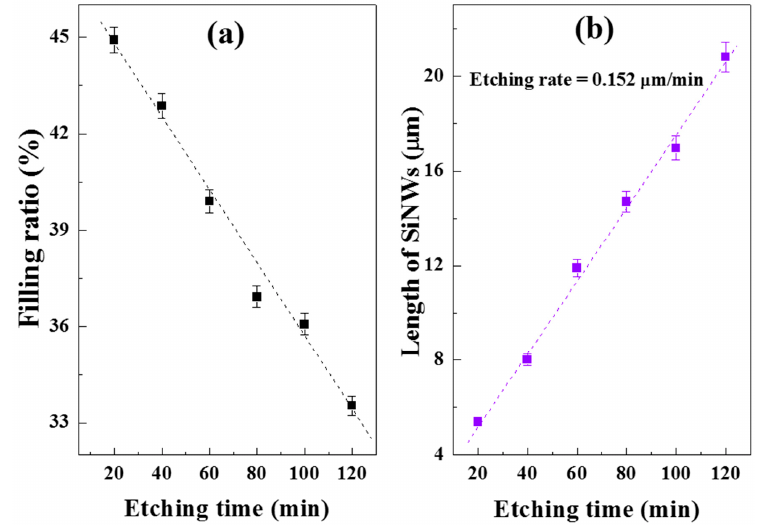
Figure 4. Variation of the ( a ) filling ratio and ( b ) length of SiNWs as a function of etching time.